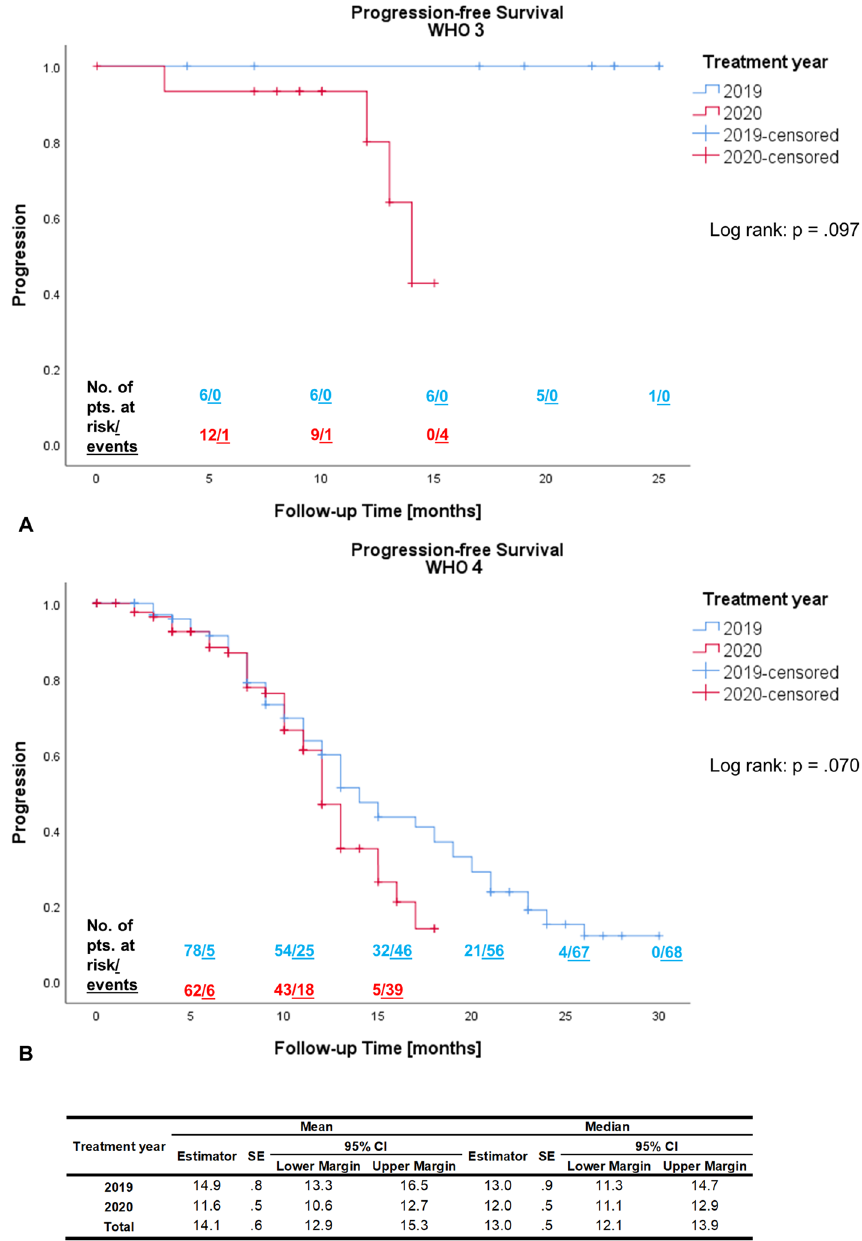
Figure 2. Kaplan–Meier estimator for progression-free survival (PFS) compared between the 2019 and 2020 cohorts with WHO Grade 3 ( A ) and WHO Grade 4 ( B ) gliomas. Pts.—patients; SE—standard error; 95%CI— 95% confidence interval. Kaplan–Meier statistics not conducted for WHO 3 due to censoring of all 2019